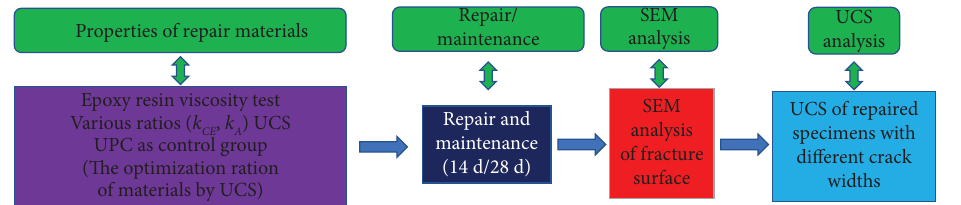
Figure 5: Schematic diagram of the experimental procedures.